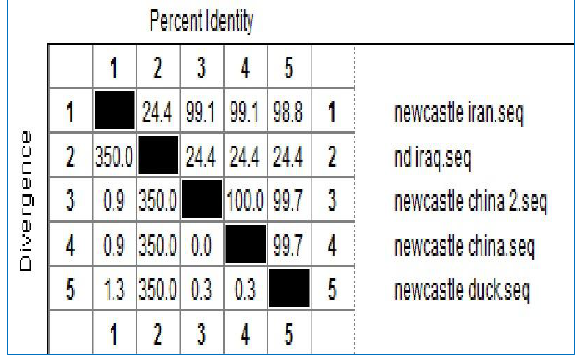
Figure, 3: The percentage of a nucleotide similarity of NDV Iraqi isolate, four velogenic isolates (DNA STAR software program was